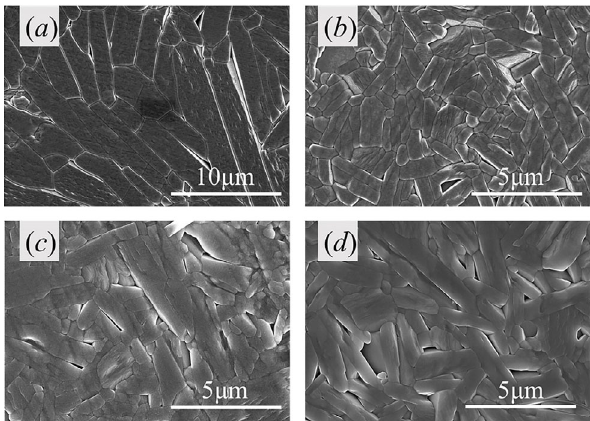
Fig. 2 SEM micrographs of SBIT ceramics with different compositions: (a) x = 0, (b) x = 0.01, (c) x = 0.02, (d) x =